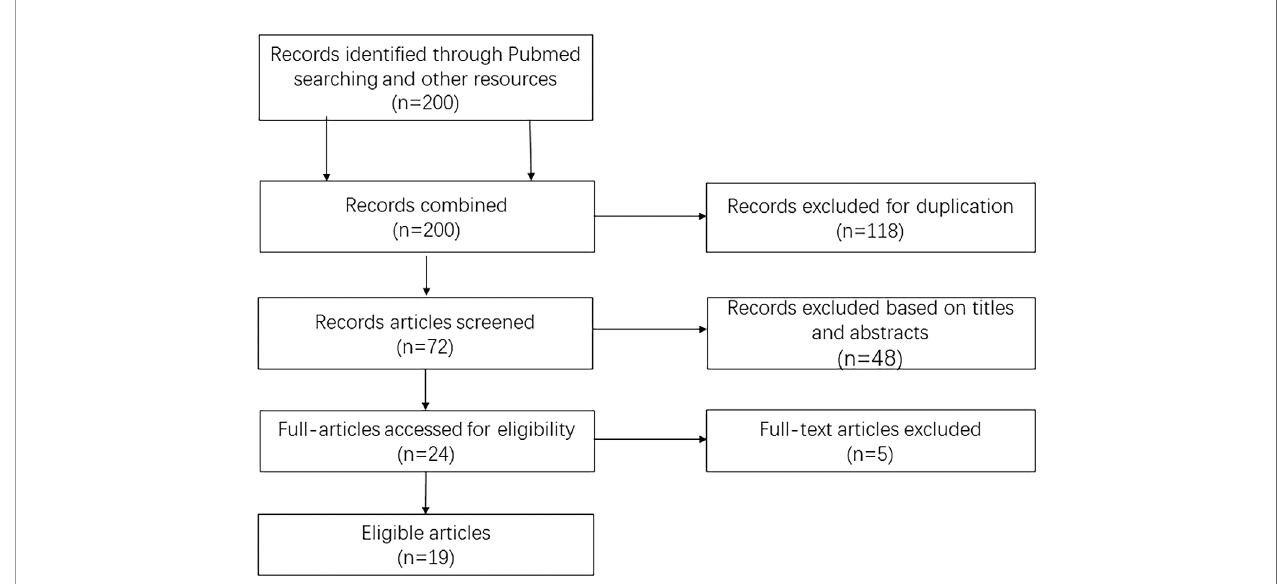
FIGURE 1 | Flowchart of the literature search and selection